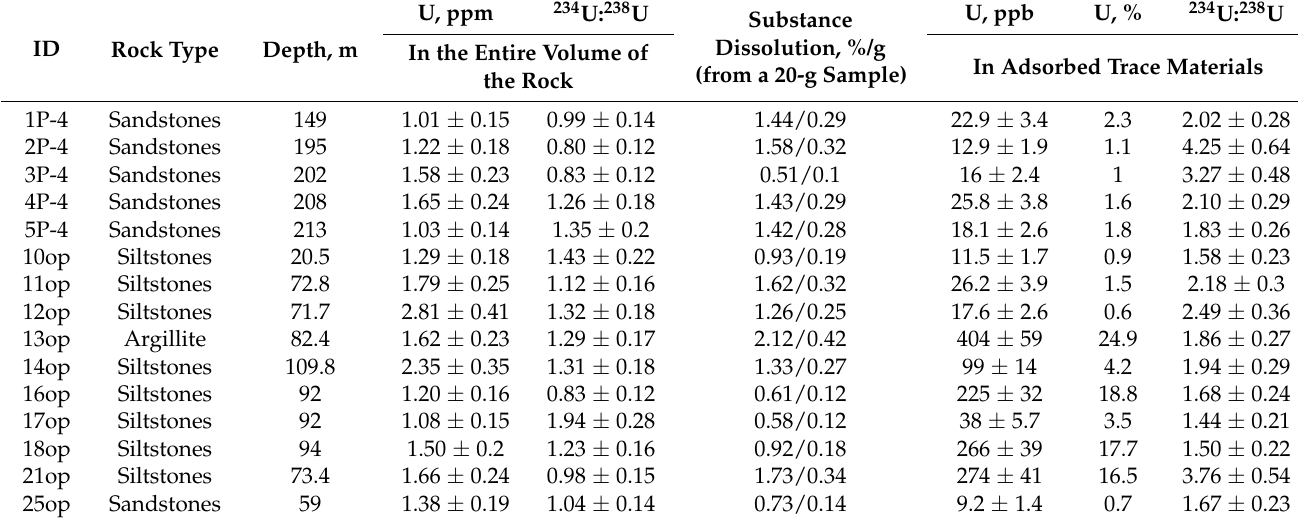
Table 2. Distribution of uranium and measured 234 U: 238 U activity ratios in adsorbed trace materials.